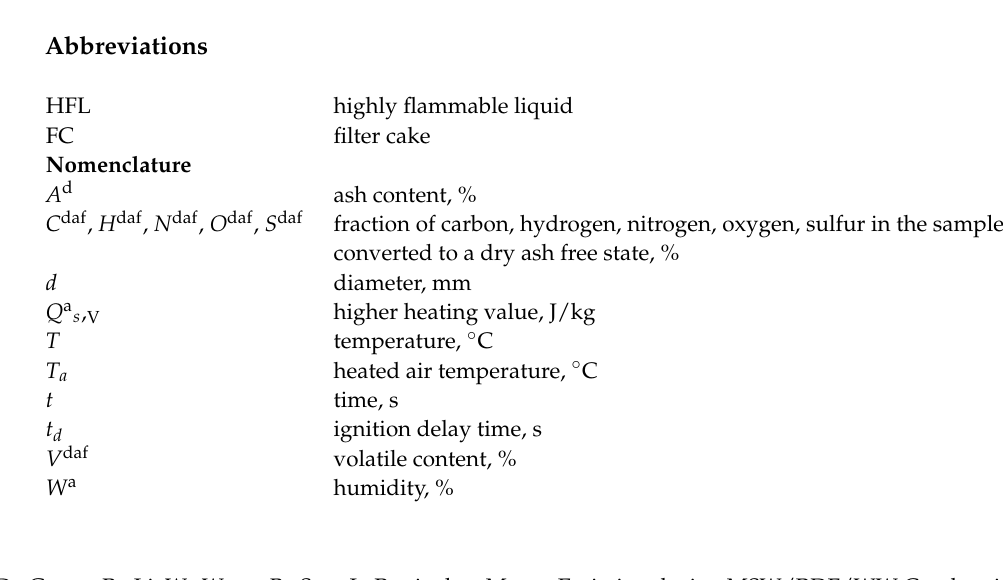
Figure S3: Dependences of the ignition delay times for composition No. 3 (40% coal + 15% rape-seed oil + 45% water) on ambient temperature at various initial temperatures; Figure S4: Dependences of the ignition delay times for composition No. 4 (40% coal + 15% tur-bine oil + 45% water) on ambient temperature at various initial